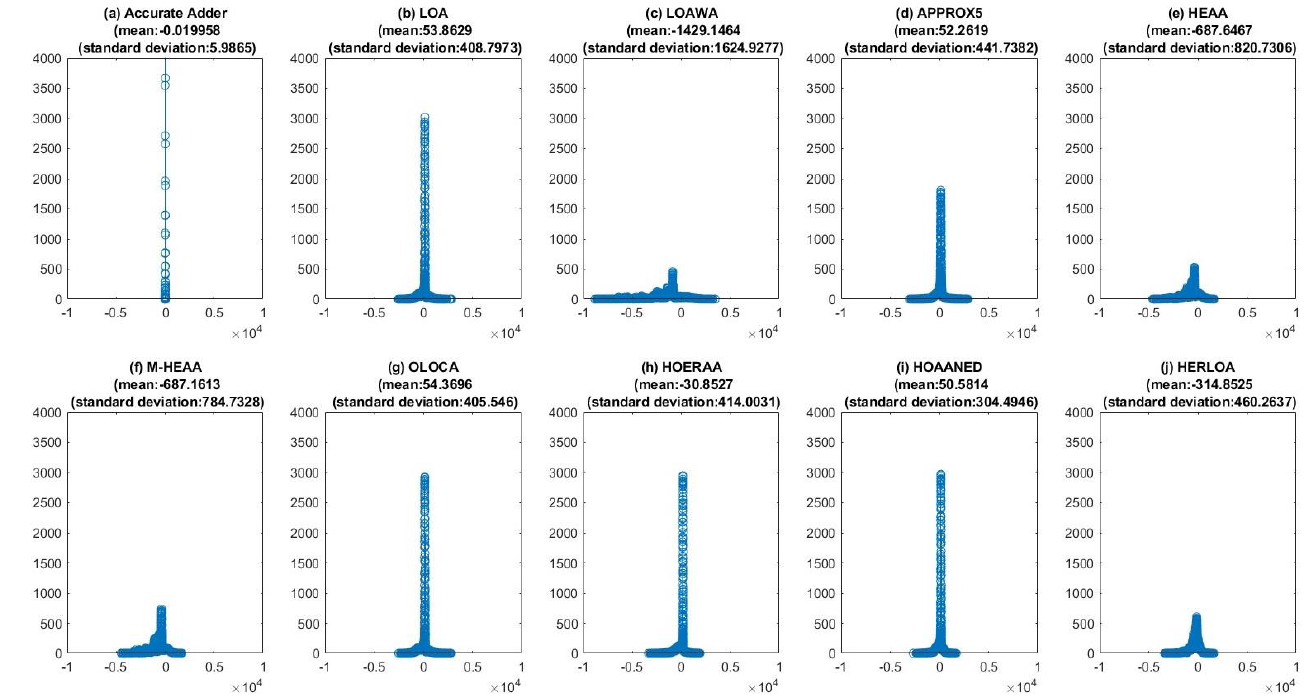
Figure 12. Plots showing the DPV between the Black Hole image compressed using accurate and approximate adders and the original Black Hole image, with the approximate adders having a 10- bit inexact part.